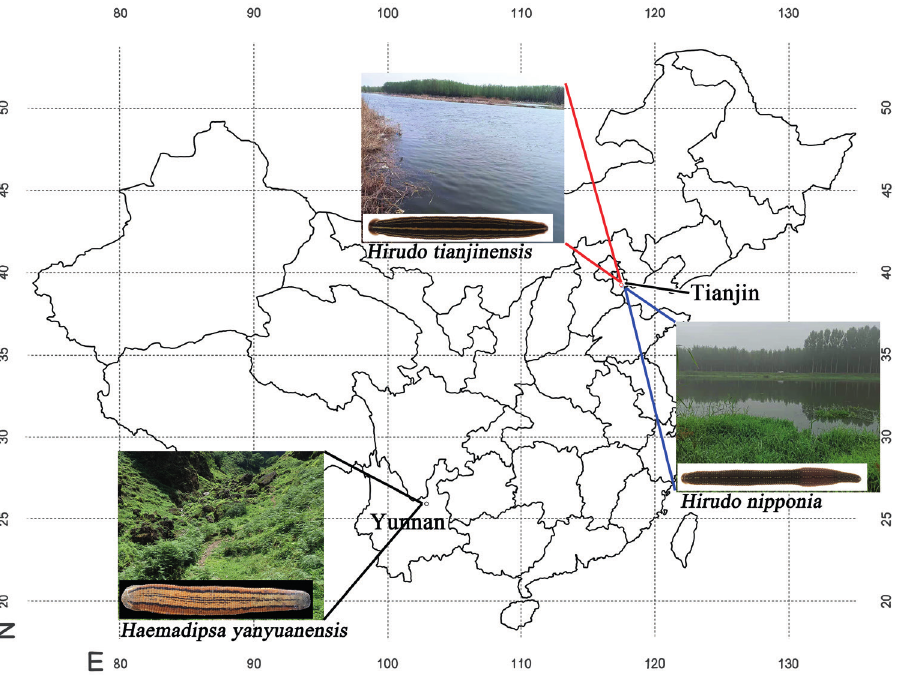
Figure 1. Map of geographic collecting locations for three species of Chinese leeches. H. tianjinensis and H. nipponia were collected in adjacent areas of Tianjin City, and Haemadipsa yanyuanensis was collected in Yunnan